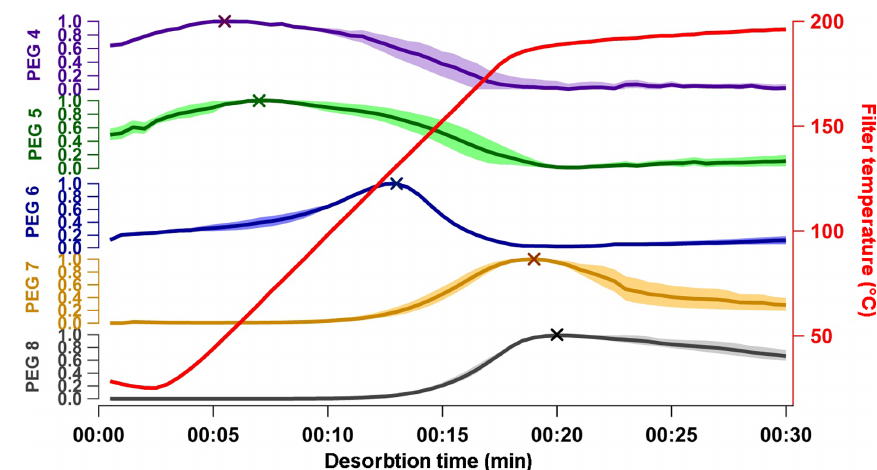
Figure 3. Thermograms from the PEG series as detected by the FIGAERO-CIMS employing iodide adduct ionization; all product ion intensities are normalized to 1. Thick coloured lines show the mean of the thermograms, and the associated shaded areas show the standard deviation of the four thermograms. Crosses show the extracted T max . The red line shows the temperature just above the filter.